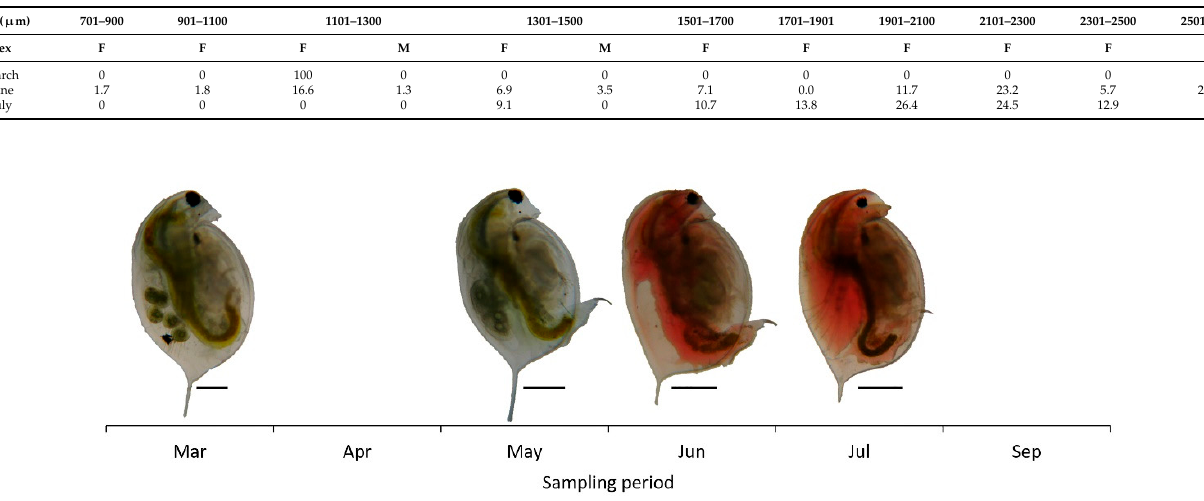
Figure 2. Biomass contribution of the main groups of the zooplankton community during the study period. Table 2. Contribution (%) of the body size ( µ m) of Daphnia magna (females (F) and males (M)) during the study period. Size( µ m)